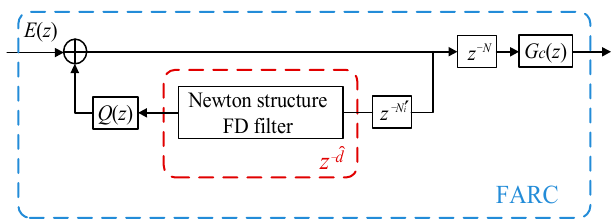
Figure 4. Schematic diagram of Newton FD filter applied to FARC.